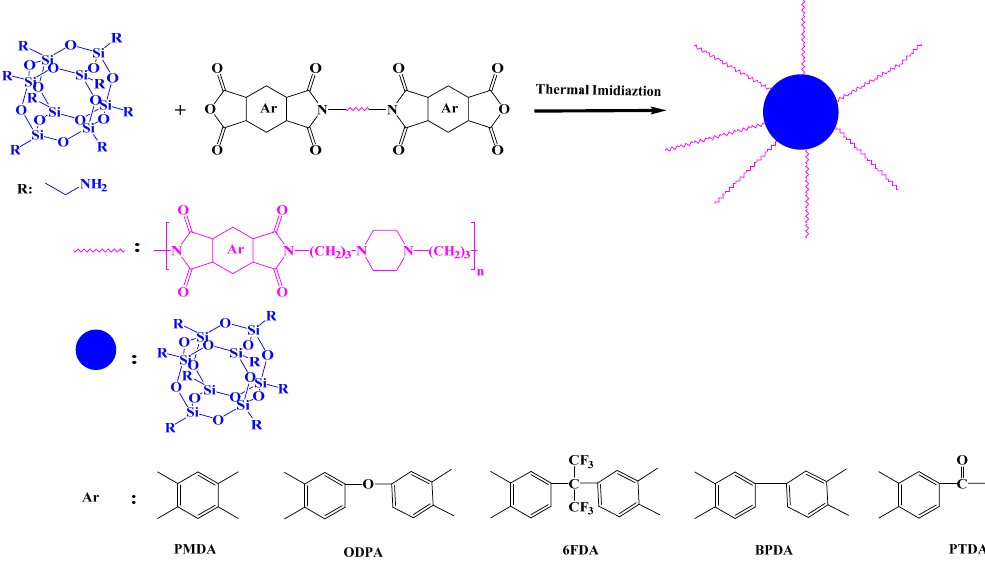
Figure 17. Preparation of star POSS/PI hybrid materials [86]. Reproduced with permission from Elsevier.